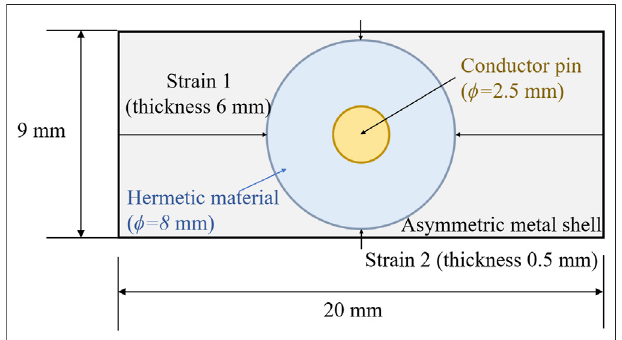
FIGURE 3 | Schematic diagram of a specially designed glass-to-metal sealing